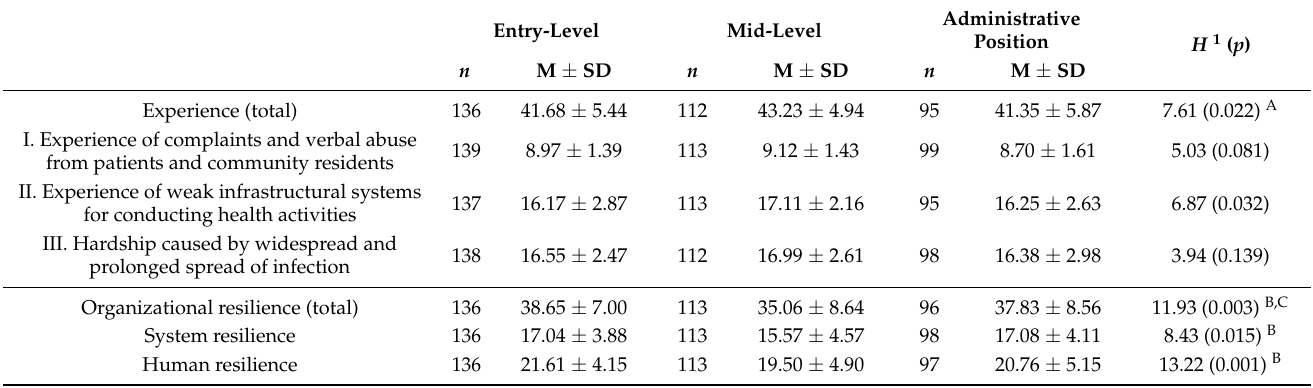
Table 5. Differences in the mean score for experience and organizational resilience by occupational position.